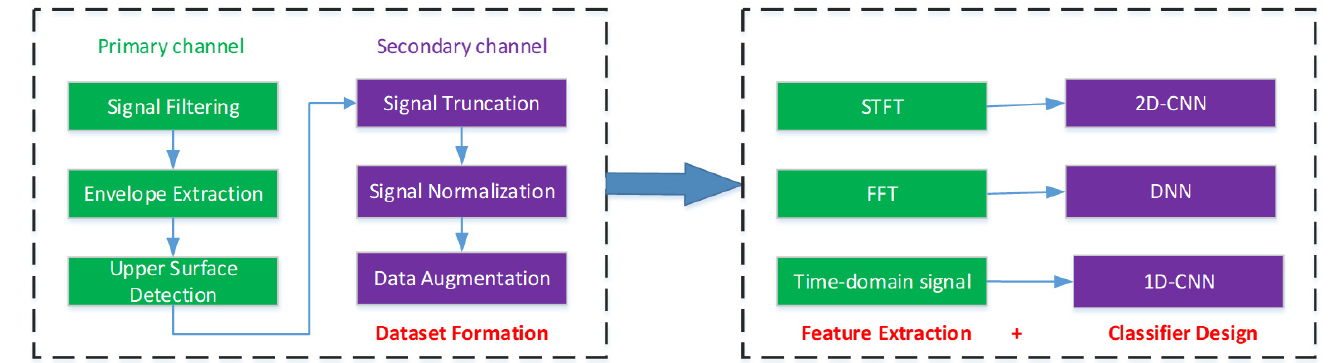
Figure 3. Binary classification with different approaches.